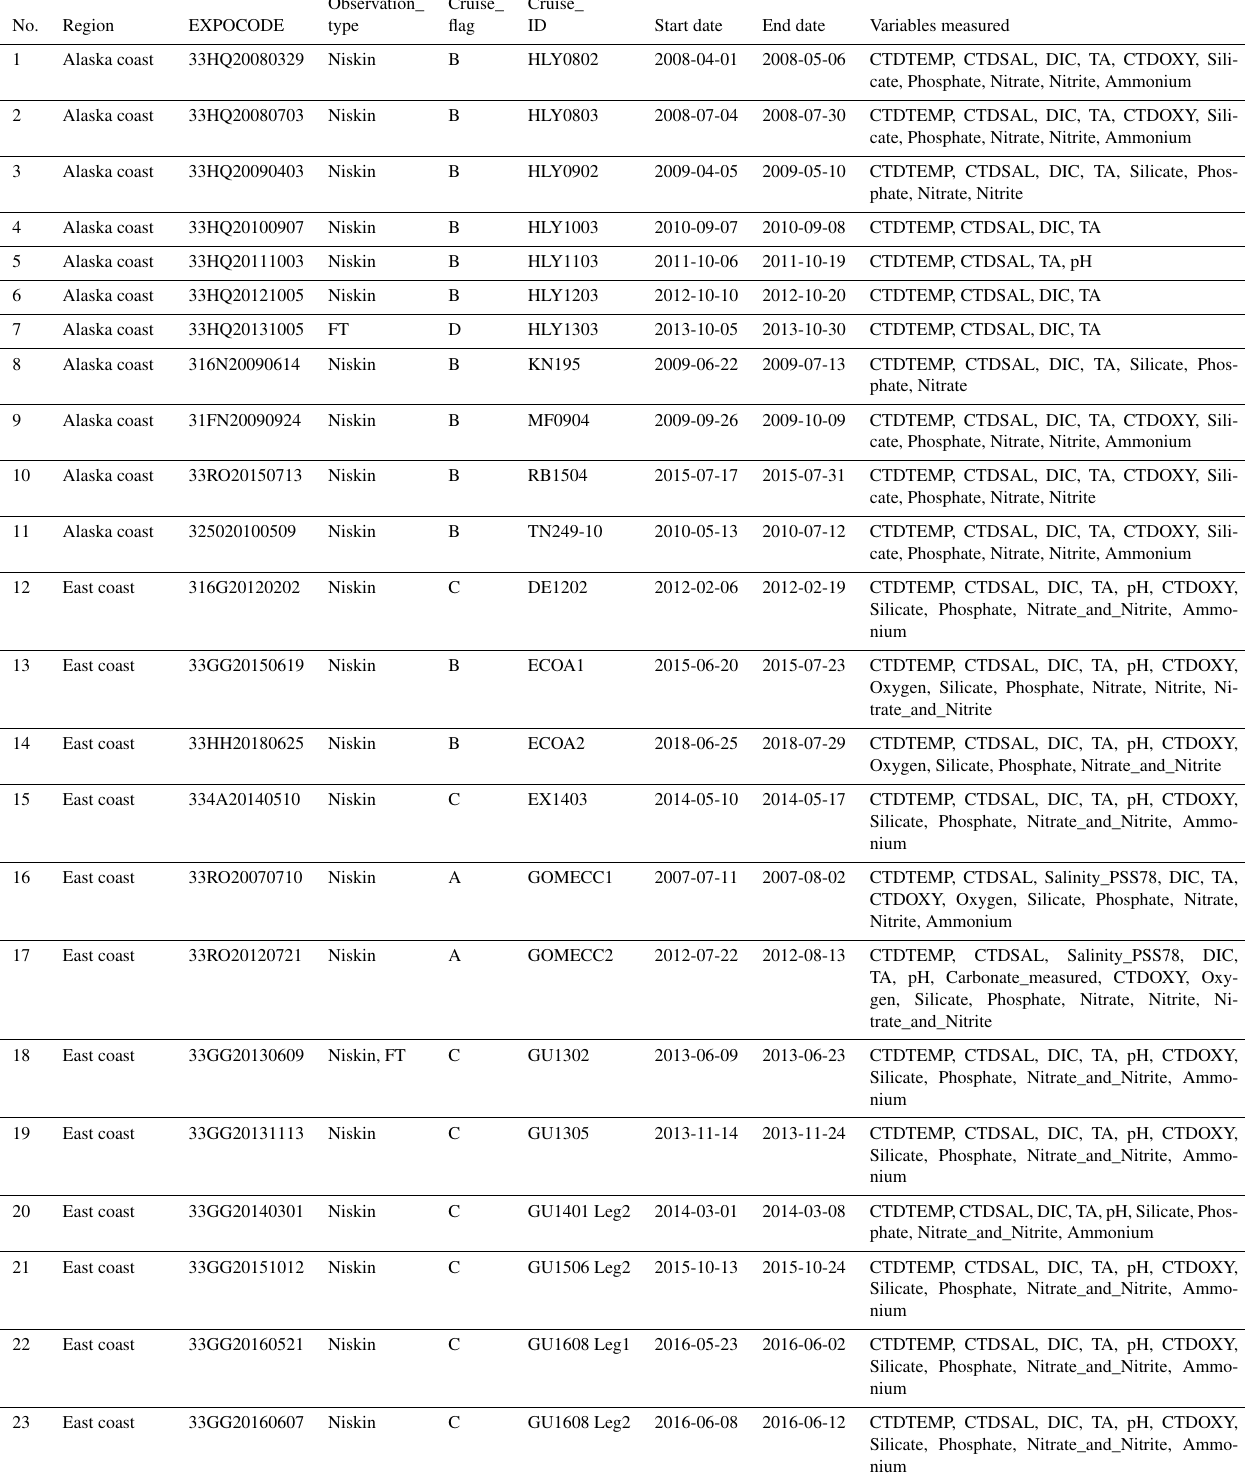
Table 2. List of cruises that are included in this version (v2021) of the CODAP-NA data product. Refer to Table 1 for the full names of the abbreviations and their units and Table 3 for definitions of the Cruise_flags. CTD is short for conductivity, temperature, and depth and refers to a package of electronic instruments that measure these properties. Start date and end date refer to the dates when data were first and last collected, respectively. For samples collected from flow-through systems, temperature and salinity were also stored in CTDTEMP and CTDSAL, respectively. GMx is short for Gulf of Mexico. FT is short for flow-through